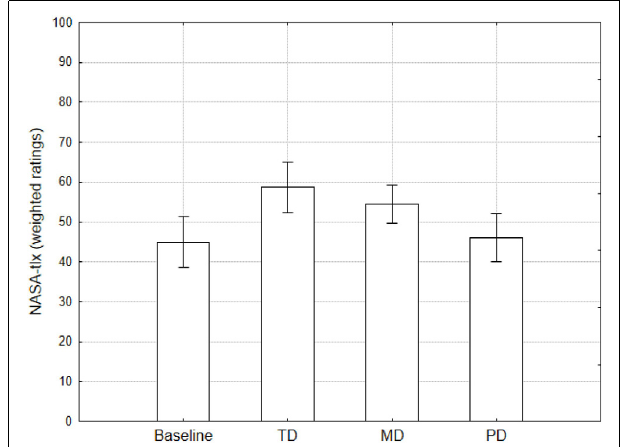
was used as a dependent variable in a repeated measures ANOVA design, using Condition (Baseline vs. TD vs. MD vs. PD) as ( F (3,87) = 15.95, p < 0.001). The faster (TD) and